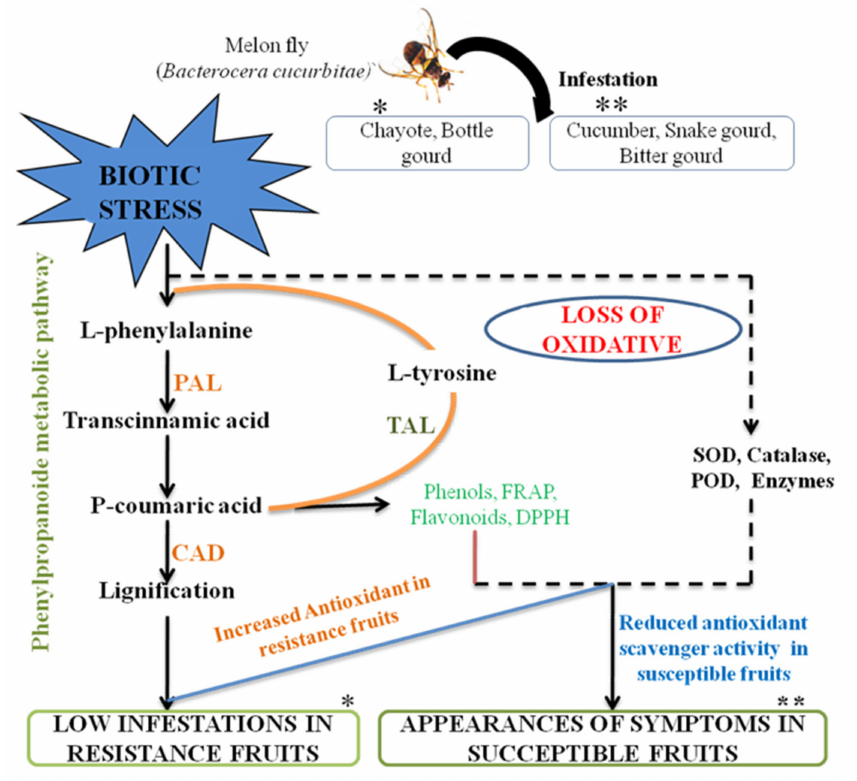
Figure 8. The phenylpropanoid pathway is a hypothetical model for the upregulation and ROS enzymes in response to biotic stress induced by melon fly infection. * Resistance; **